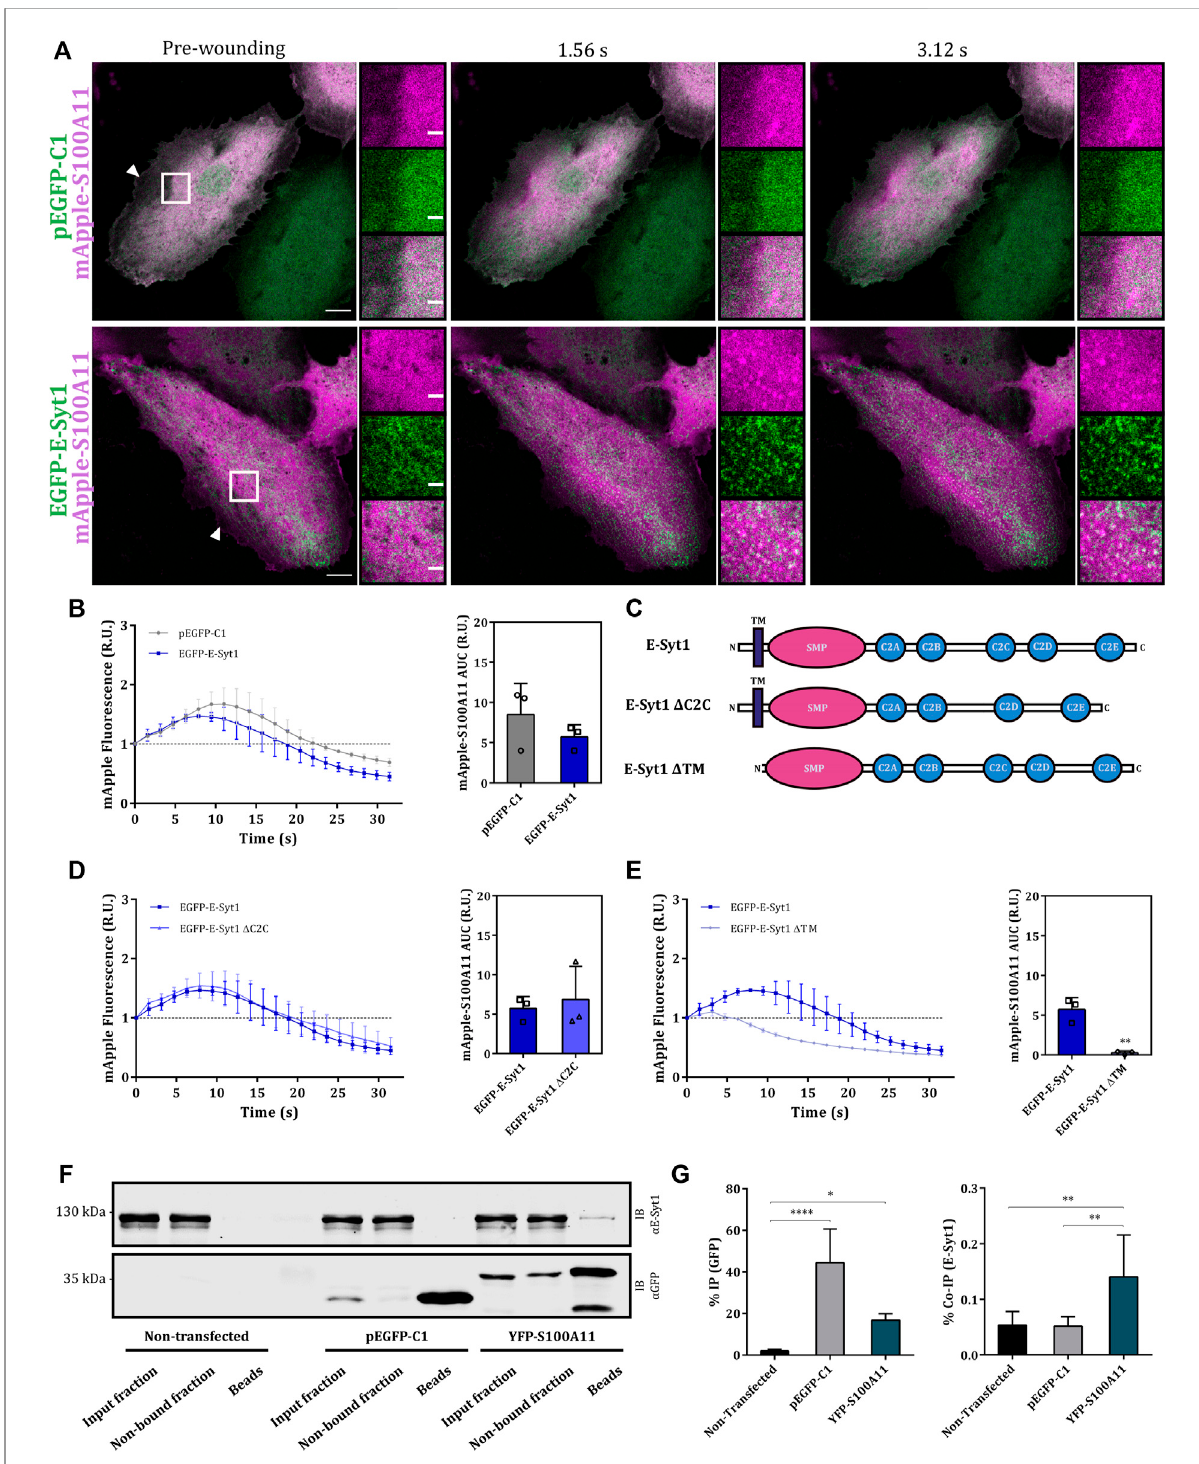
FIGURE 6 S100A11 associates with E-Syt1 in endothelial cells. (A) Representative time-lapse images of injured HUVEC expressing GFP plus mApple- S100A11 (upper panel) or EGFP-E-Syt1 plus mApple-S100A11 (lower panel) (Supplementary Video S11). Transfected cells kept in Tyrode ’ s buffer supplementedwith2.5 mMCa 2+ wereinjuredatthelateralmembraneedge(whitetrianglesrepresentthewoundsites).Woundingoccurredatt=0; pre-woundingandpost-woundingtimepointsareshown.Scalebars=10